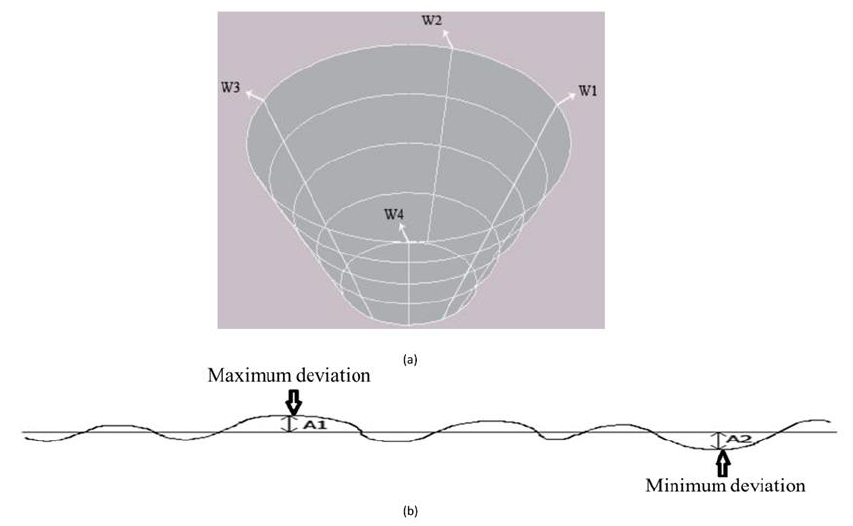
Figure 3. ( a ) Surface waviness paths and ( b ) maximum and minimum deviation along path. The side angle is the angle formed by the side walls of parts with respect to the horizontal XY-plane, as shown in Figure 1b. The side angle error is defined as the difference between the actual and designed side angle (60 ◦